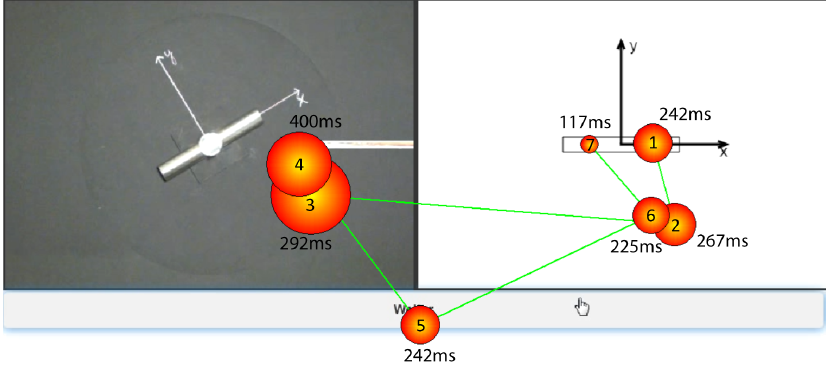
FIG. 2. Visualization of the scan path of a subject. The red circles represent fixations. The green lines show saccadic movements. The order in which the fixations occurred is described by the number in the circles. The duration of each fixation is indicated by the size of the corresponding circle and, in addition, is displayed next to the